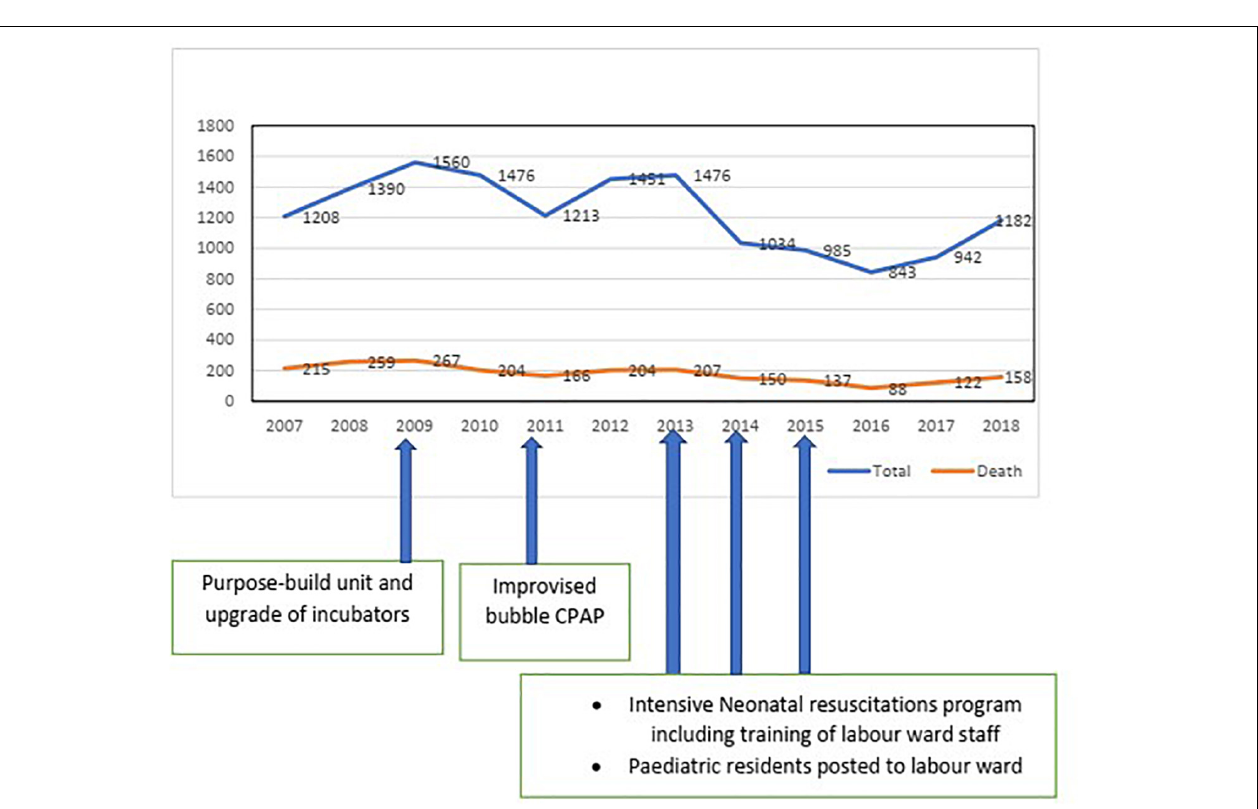
FIGURE 1 | Admission and mortality trends with timing of interventions during the study